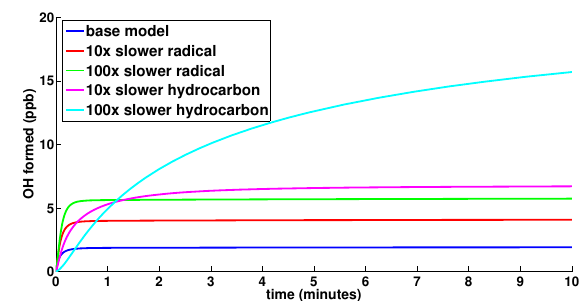
Fig. 6. Box model simulations for OH production in isoprene + NO 3 system. Blue: base case described in Table 2; Red: RO 2 + HO 2 and RO 2 + NO 3 rate constants reduced by factor of 10; Green: RO 2 + HO 2 and RO 2 + NO 3 rate constants reduced by factor of 100; Pink: isoprene + NO 3 rate constant reduced by factor of 10; Light Blue: isoprene + NO 3 rate constant reduced by factor of 100. Initial conditions: 150 ppb N 2 O 5 , 800 ppb isoprene, 50 ppb NO 2 .